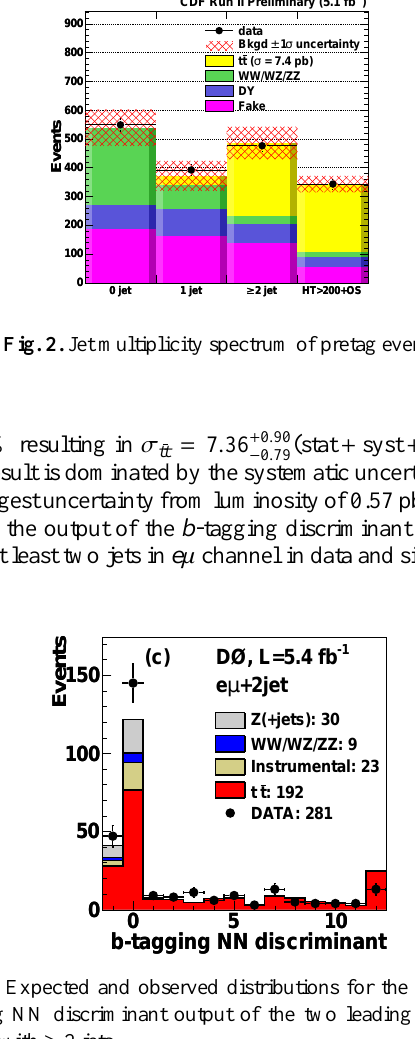
Fig. 3. Expected and observed distributions for the smallest b - tagging NN discriminant output of the two leading jets for e µ events with 2 ≥